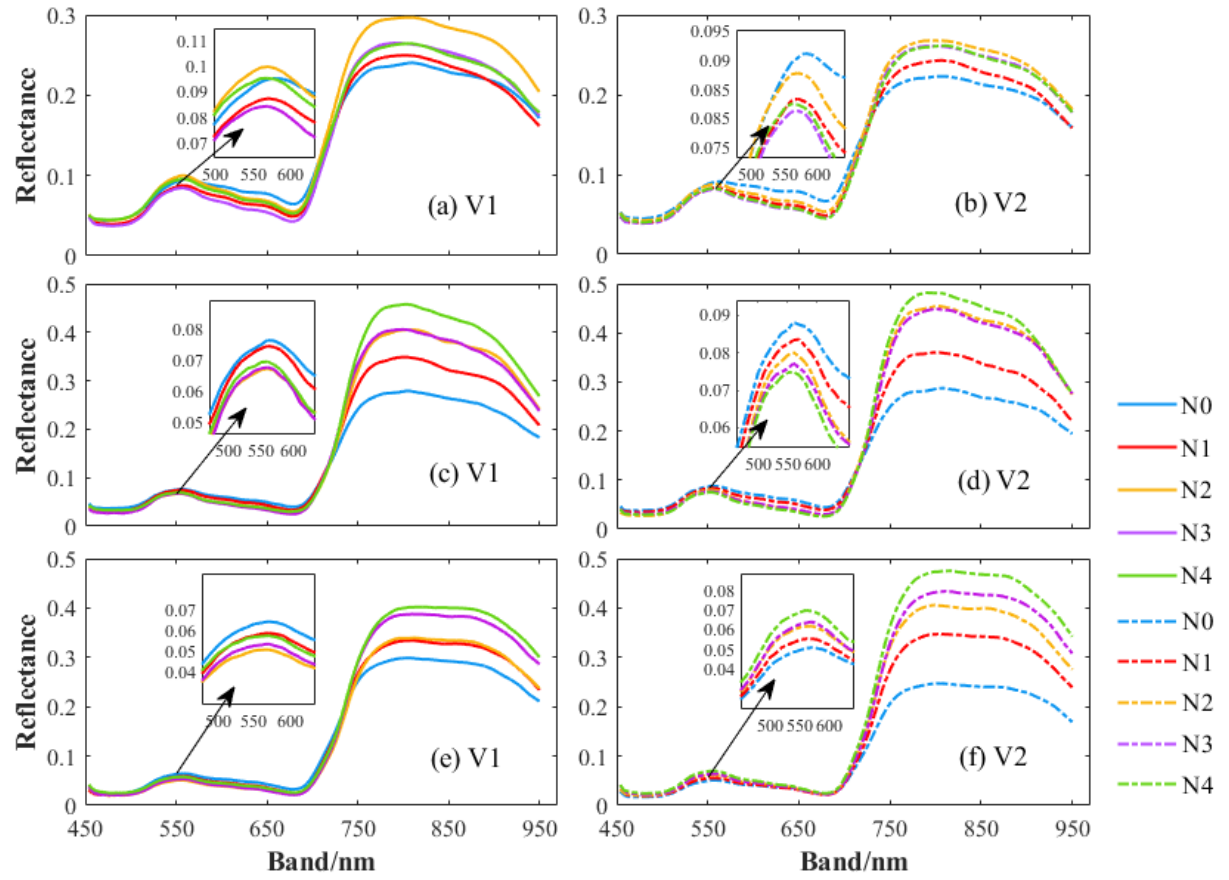
Figure 3. Canopy reflectance spectra of different rice varieties (V1 = Meixiangzhan 2 and V2 = Wufengyou 615) with different nitrogen fertilization levels. Reflectance of ( a ) V1 and ( b ) V2 at the tillering stage, ( c ) V1 and ( d ) V2 at the panicle initiation stage, and ( e ) V1 and ( f ) V2 at the heading stage.